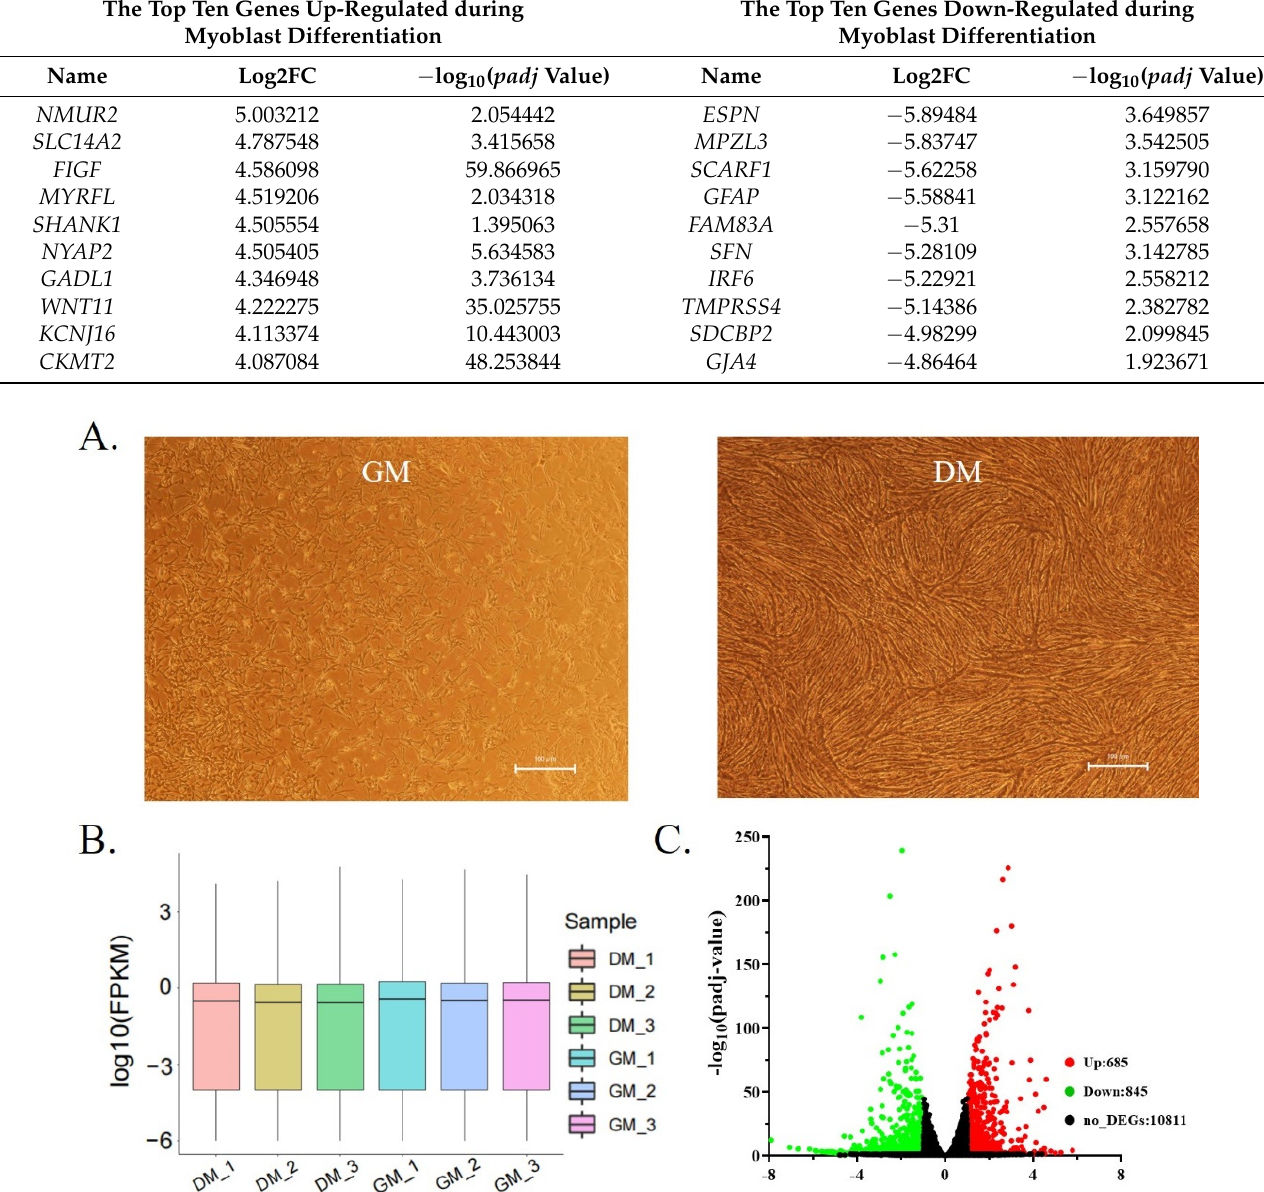
Table 2. The top ten DEGs.